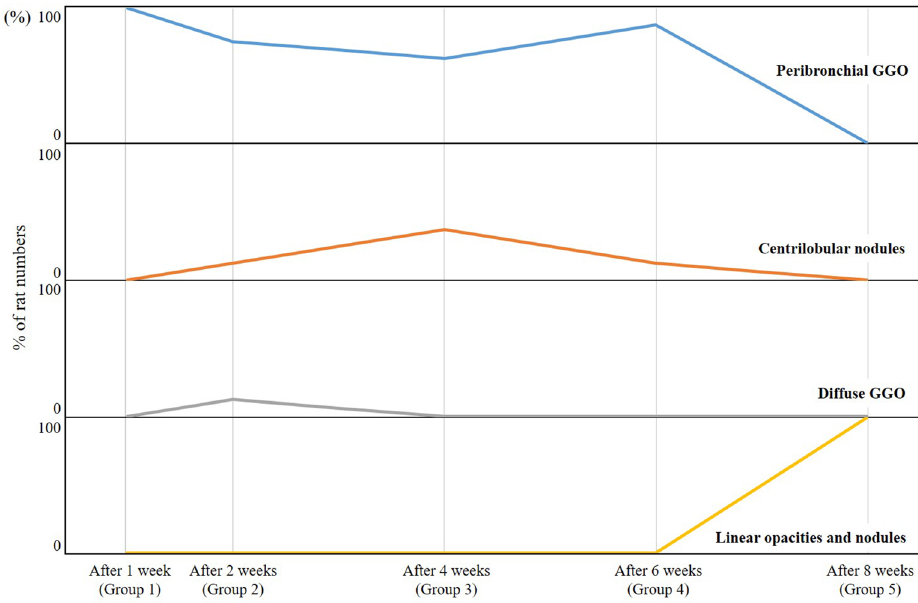
Figure 1. Changes of the CT findings according to the groups. Peribronchial GGO was observed in all rats 1 week after PHMG exposure, then slightly decreased through 2 weeks to 6 weeks after PHMG exposure, and disappeared at 8 weeks after PHMG exposure. Centrilobular nodules peaked at 4 weeks (3 of 8 rats, 37.5%) and then decreased. Linear densities and nodules were observed at 8 weeks (8 of 8 rats,